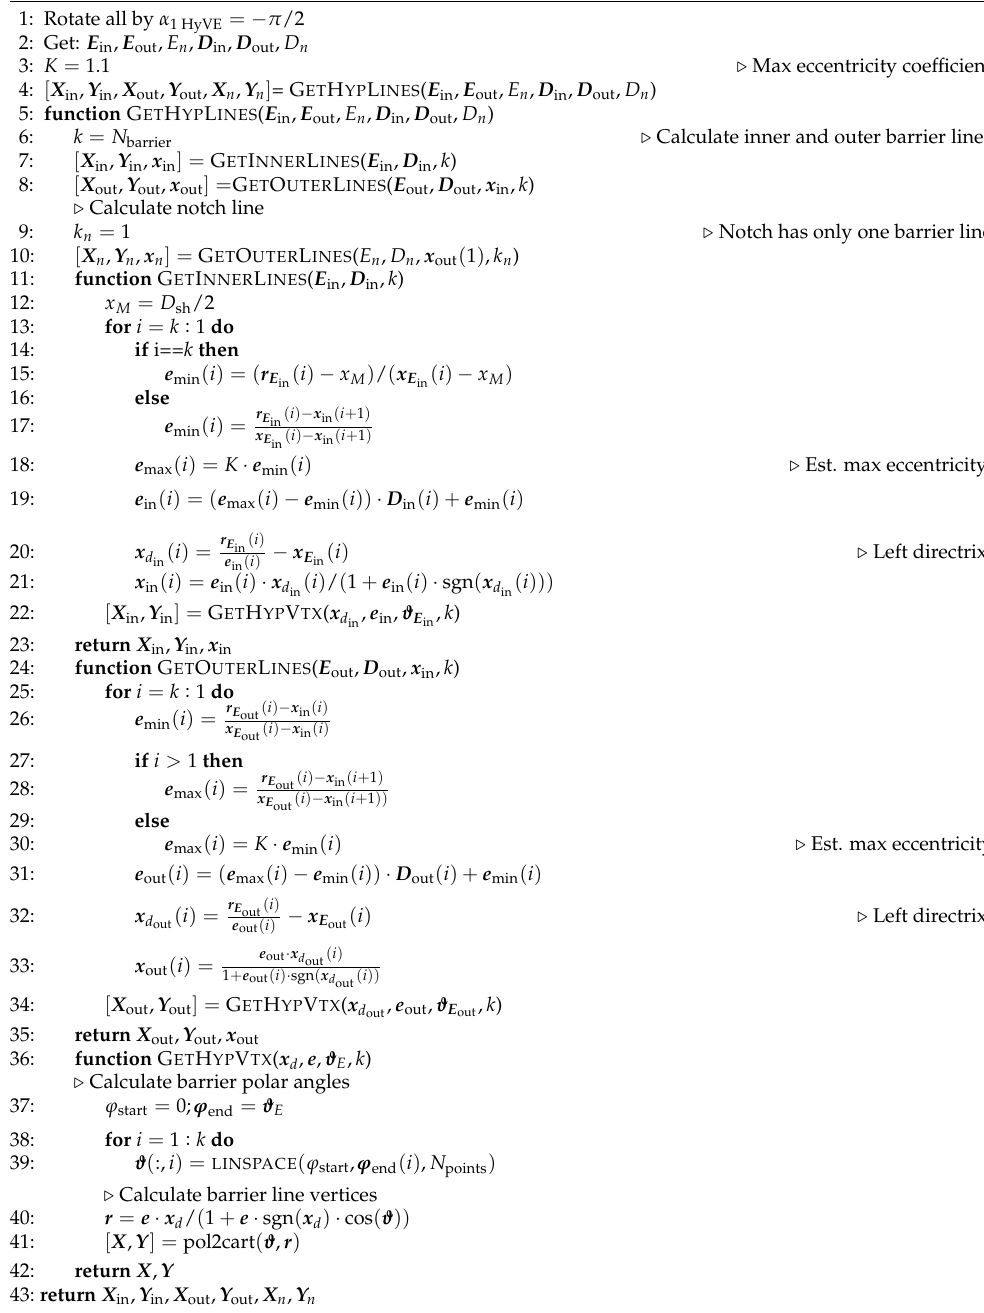
Algorithm 3 Construction of Hyperbolic